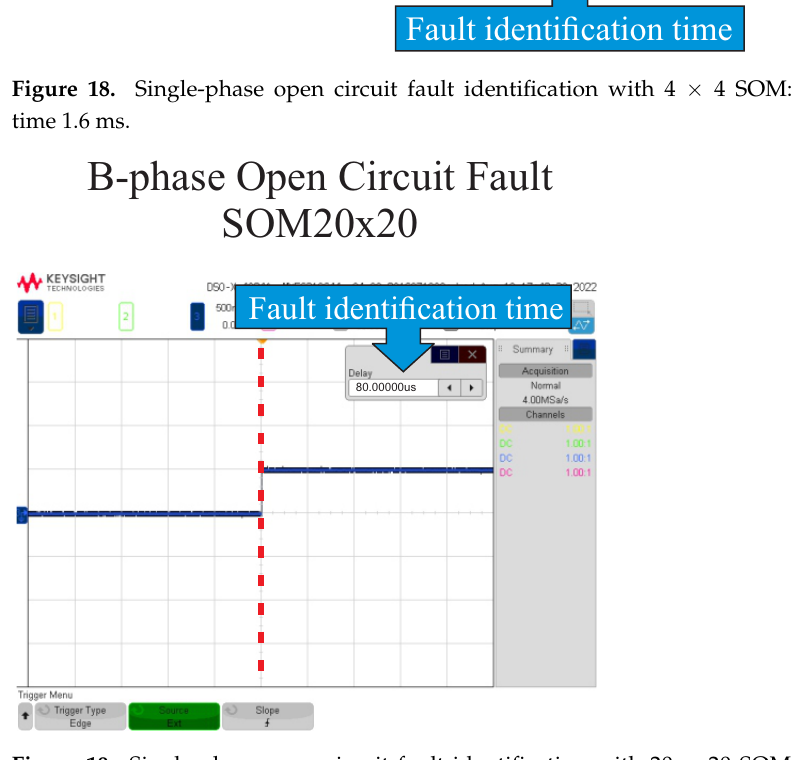
Figure 19. Single-phase open circuit fault identification with 20 × 20 SOM: Phase B; detection time 80 µ